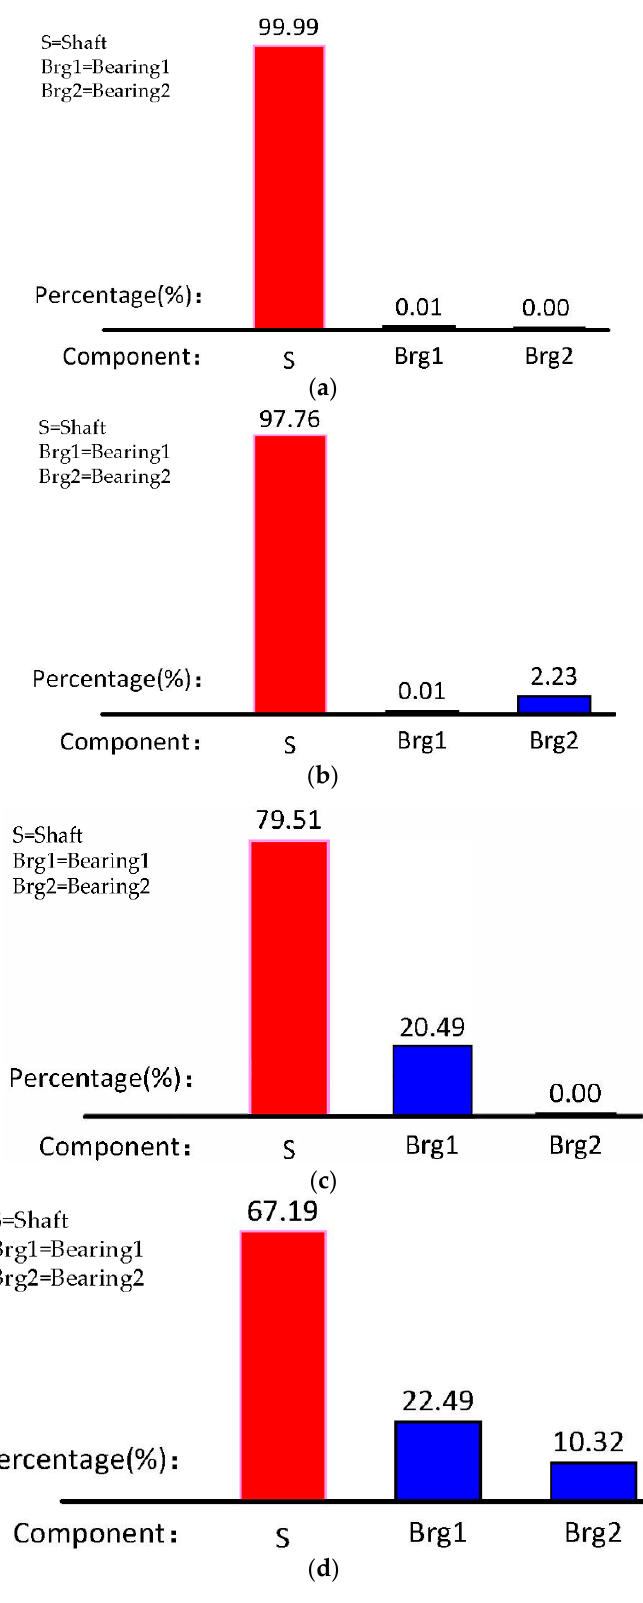
Figure 12. Energy distribution of unbalanced single-side cantilevered rotor system: ( a ) working condition 1; ( b ) working condition 2; ( c ) working condition 3; ( d ) working condition 4.